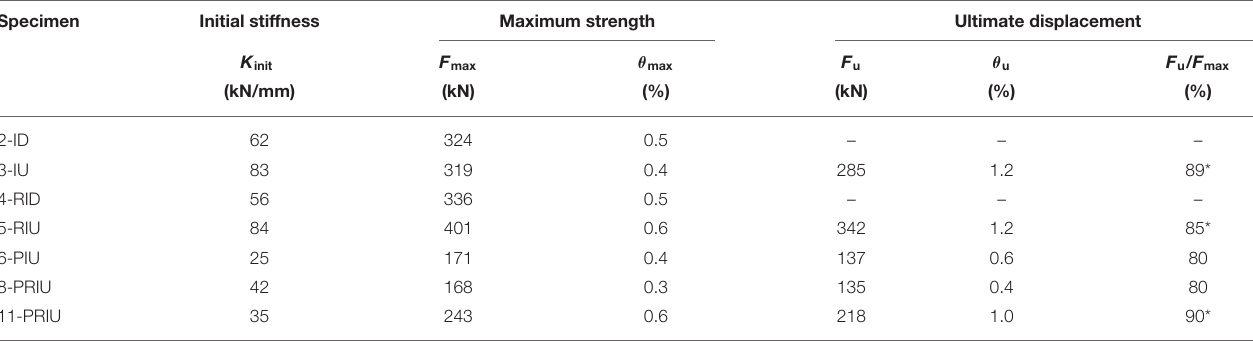
TABLE 4 | In-plane test results (infill contribution; *ultimate condition, i.e., 20% F max degradation, not reached). Specimen Initial stiffness Maximum strength Ultimate